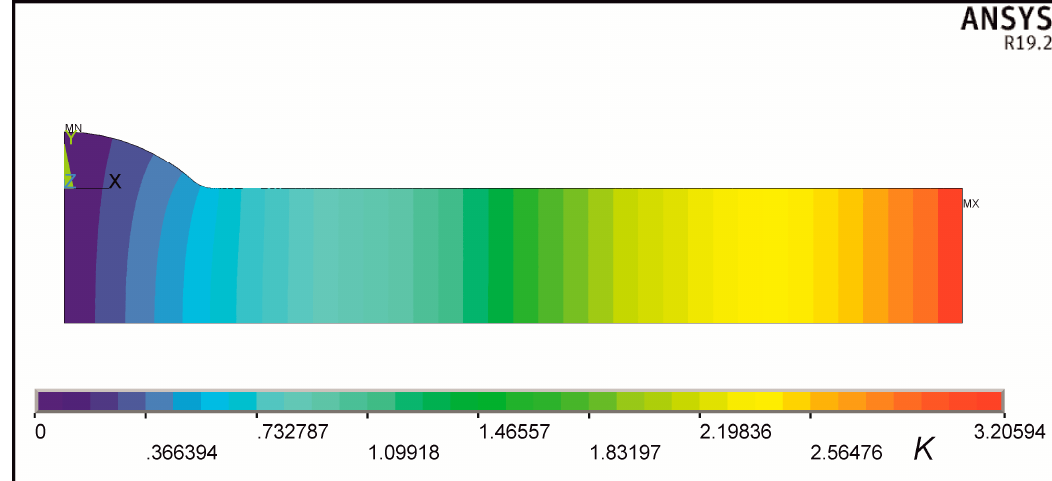
Figure 7. Temperature field and equipotential lines in heat conducting element.